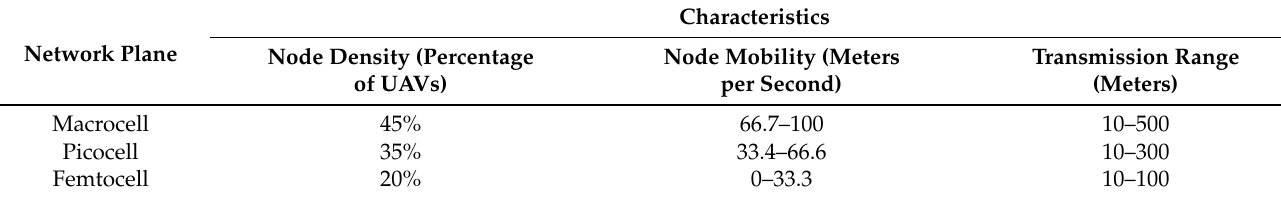
Table 5. Characteristics of network